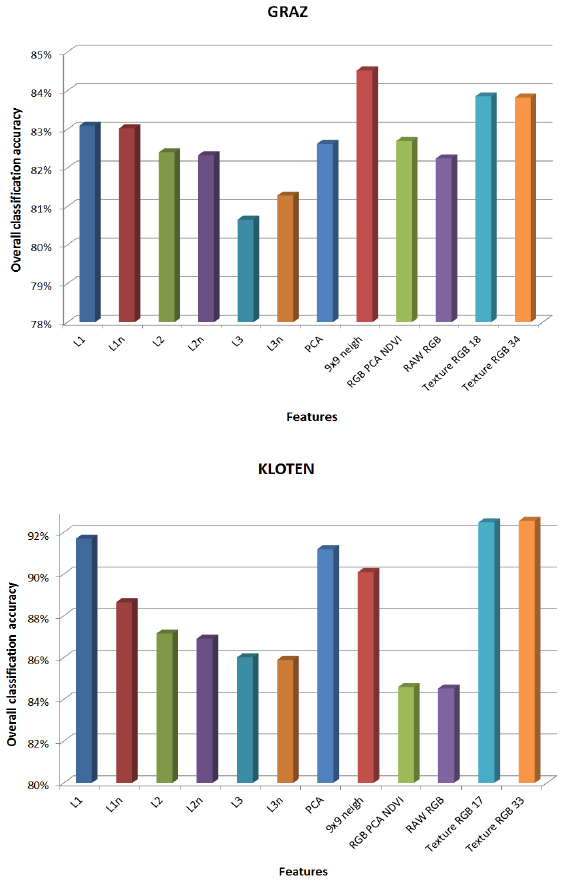
Figure 4. Overall classification accuracies. T = 50, D = 15. Please note the different scales on the